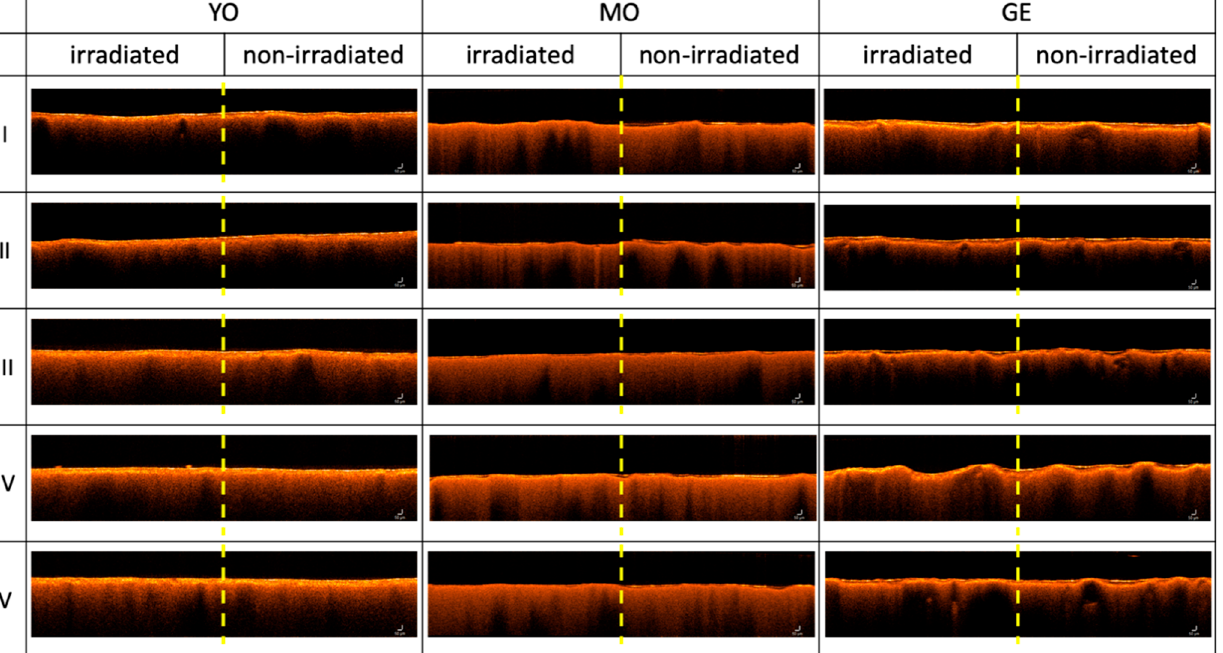
Table 6. Maximum, minimum and mean thickness values (respectively d max , d min , d r ) of the shellac layer before and after I–V laser treatments. Standard deviation is a measure of the thickness variability. N.d. stands for not detectable thickness (i.e., below the instrumental limit of detection which is about 3.5 μ m in z ).